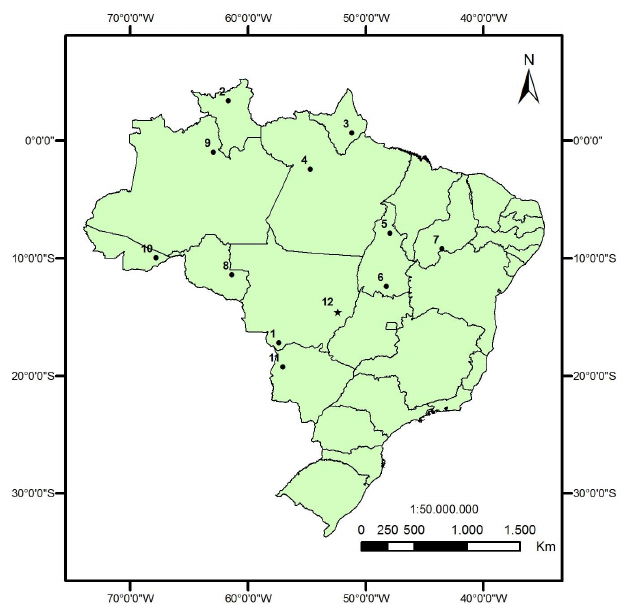
Figure 1. Geographical distribution